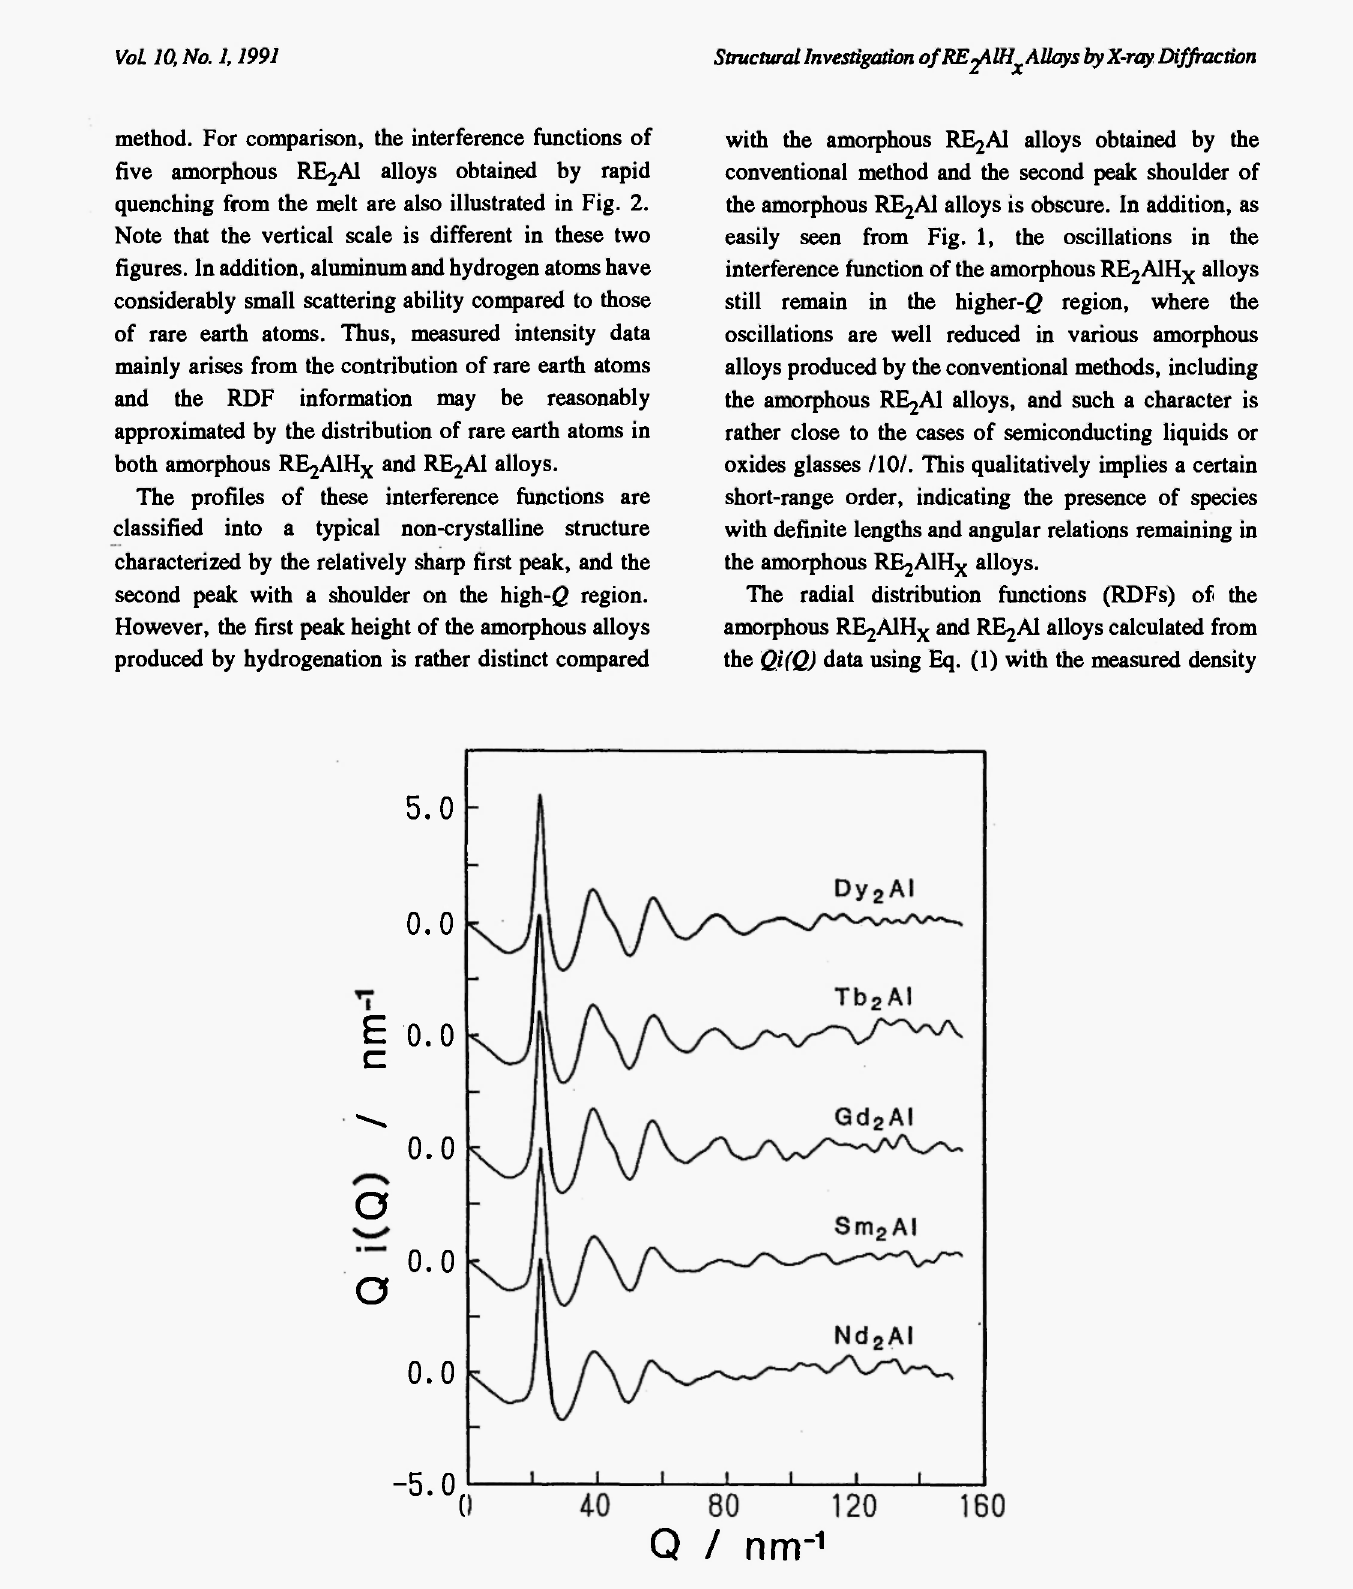
of amorphous RE 2 AI alloys produced by rapid quenching from the melt. Fig. 2: Interference functions